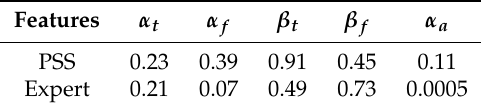
Table 4. Asymmetries in PSS and expert